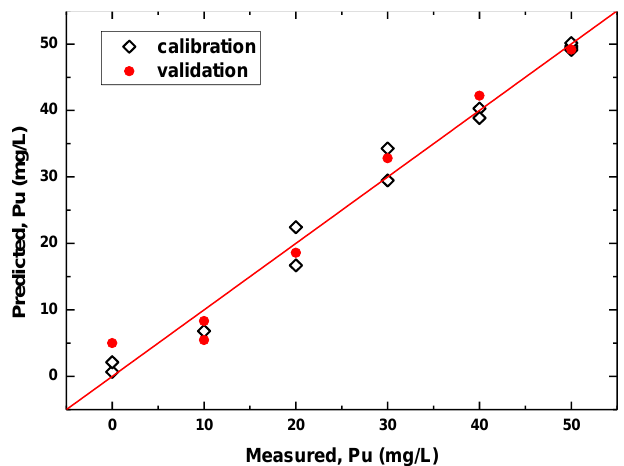
Figure 4. “Measured vs. predicted” plot for partial least squares regression (PLS) model based on potentiometric sensor data obtained in simulated PUREX solutions. Validation with 7 randomly chosen samples, 4 latent variables, R 2 0.98/0.94, RMSE 2.0/4.4 mg/L (calibration/validation).